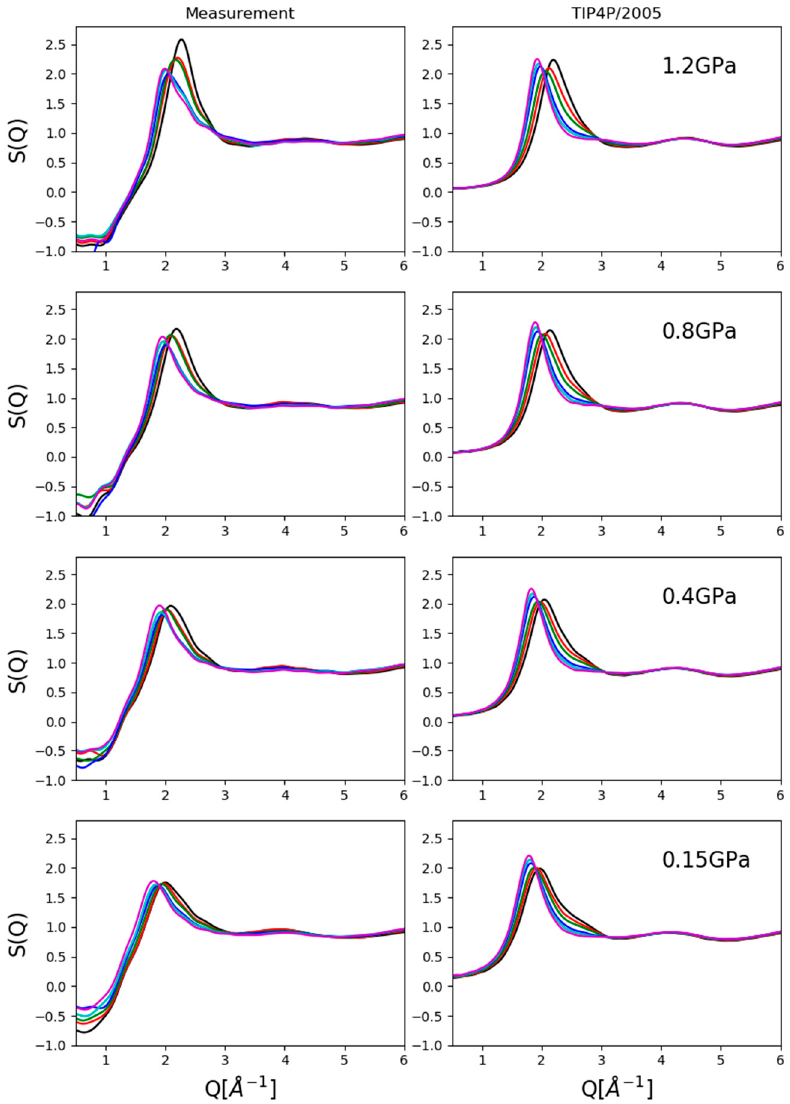
Figure 2. Comparison of measured data and computer simulation results with the TIP4P/2005 water potential as a function of composition at given pressure values. General trends, like the shift of the first peak position and the emerging high Q shoulder on the first maximum, were reproduced satisfactorily, although exact intensities were not. Black: 10 mol% methanol; red: 20 mol%; green: 30 mol%; blue: 50 mol%; cyan: 60 mol%; magenta: 70 mol%.